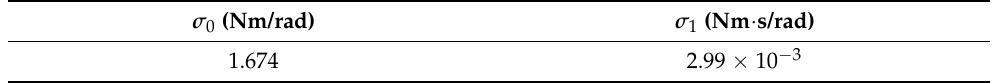
Table 2. Dynamic parameters of the LuGre